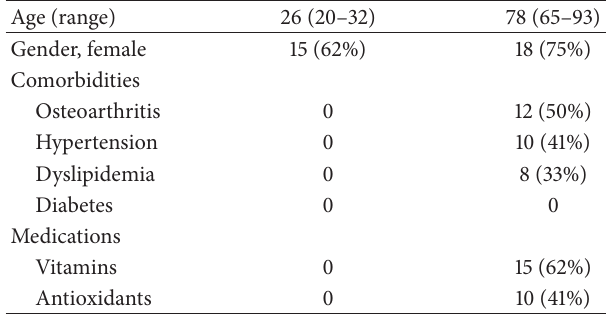
Table 1: Description of the aged and young